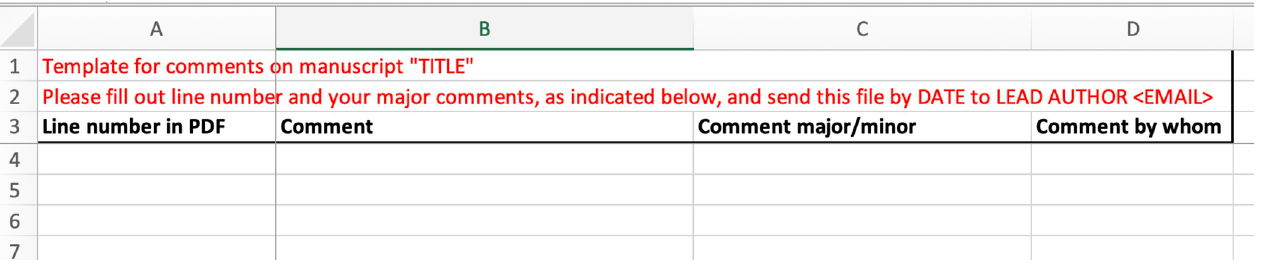
PLOS Computational Biology | https://doi.org/10.1371/journal.pcbi.1010185 June 30,